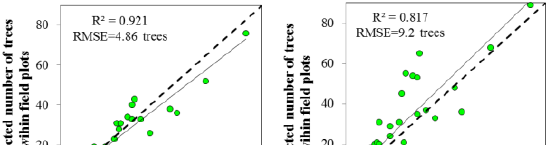
Figure 4. (a) Original CHM, (b) Median filter, (c) Weighted mean filter